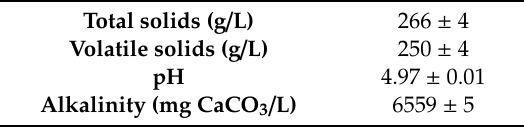
Table 1. Olive mill solid waste characterization.